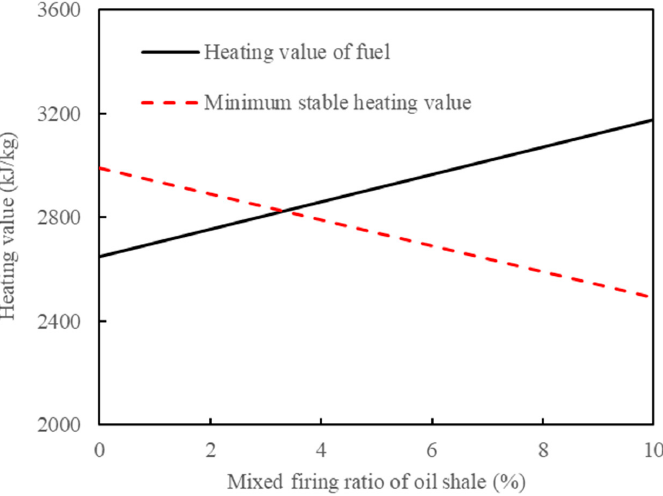
Figure 8. Changes in fuel heating value and its minimum steady burning calorific value with oil shale mixing ratio.